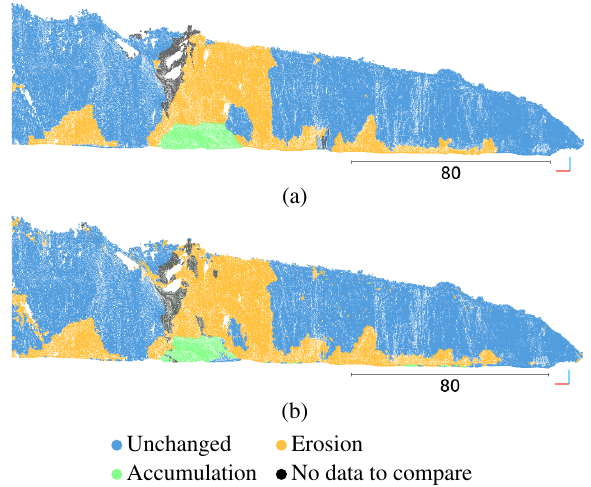
Figure 4. Results on east part of the cliffs between 2017 and 2018 acquisition. Points of the ground truth (a) and in Siamese KPConv results (b) are colorized according to the